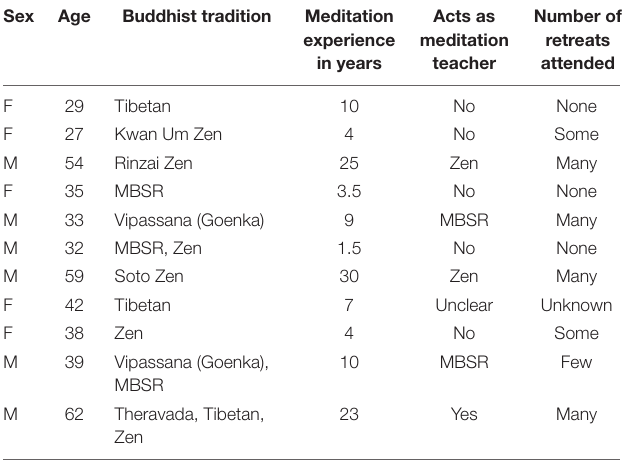
TABLE 2 | Characteristics of interviewees, ordered by interview